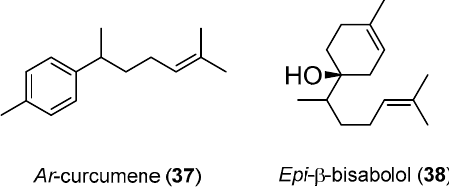
Figure 4. Chemical structure of the compounds 37 and 38 .